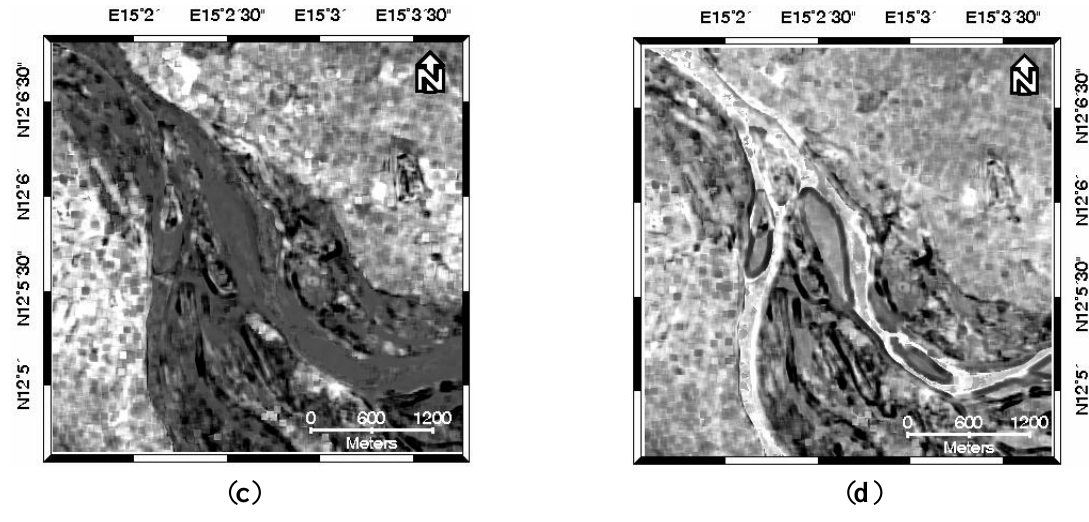
Figure 4. The component images generated from the experiment: ( a ) MAD components (RGB color composite: 4 3 2); ( b ) the cross-fused image (RGB color composite: 3 2 1); ( c ) the mean UIQI generated from the MFI method; ( d ) the mean UIQI generated from the proposed